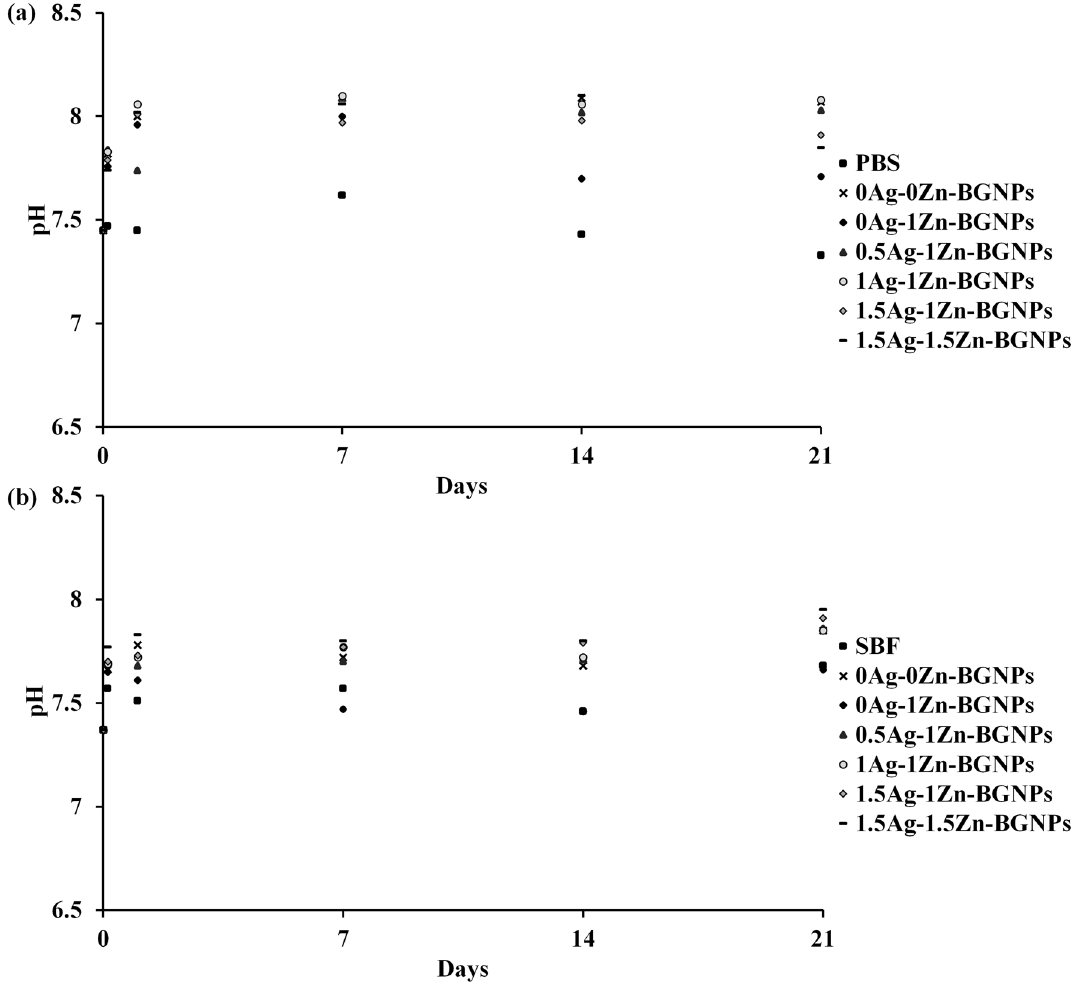
Figure 3. The pH solution of 0Ag–0Zn-BGNPs, 0Ag–1Zn-BGNPs, 0.5Ag–1Zn-BGNPs, 1Ag–1Zn-BGNPs, 1.5Ag–1Zn-BGNPs, and 1.5Ag–1.5Zn-BGNPs in ( a ) PBS solution at pH 7.4 and ( b ) SBF solution at pH